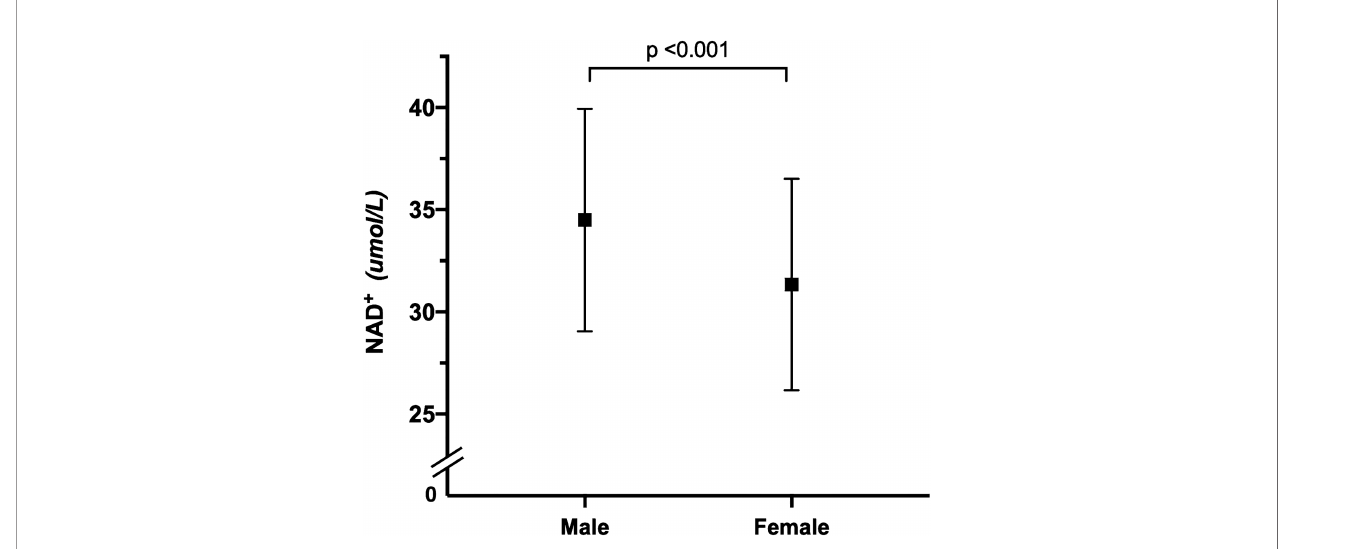
FIGURE 2 | Gender difference in whole blood NAD + contents. Comparison of whole blood NAD + contents between men (N = 798) and women (N = 720). The dots and error bars represent mean and standard deviation of blood NAD + contents in men and women,